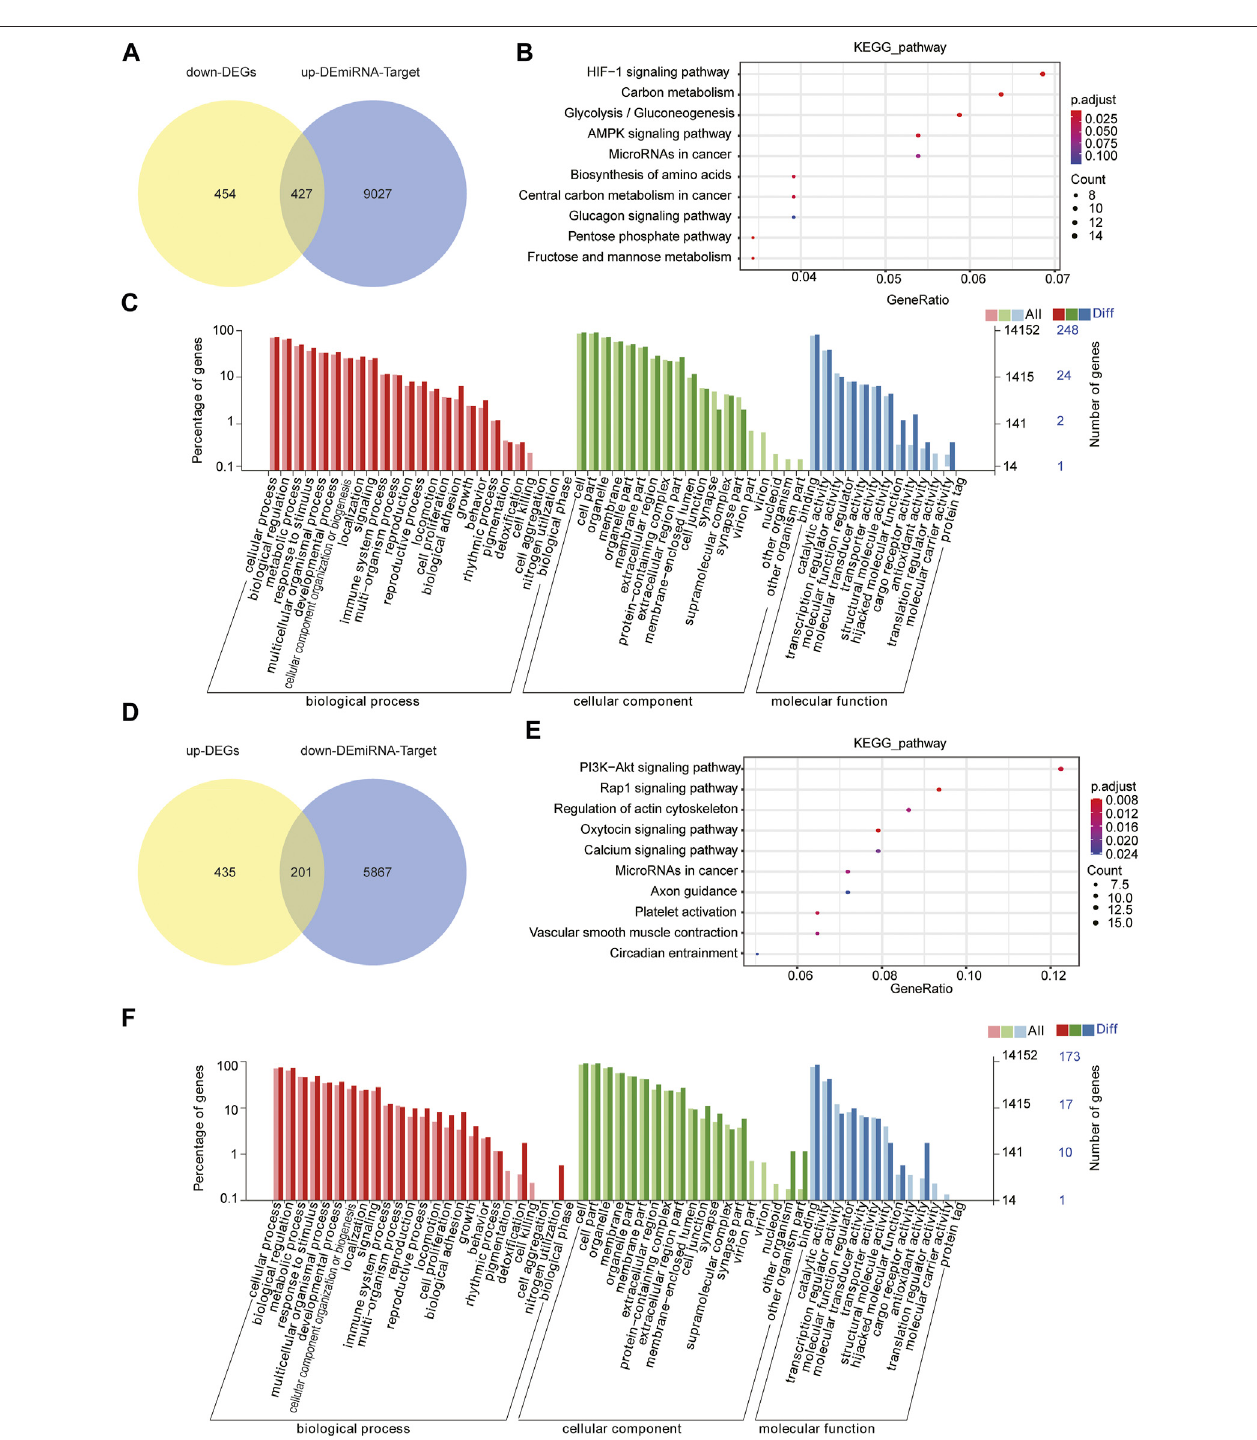
FIGURE 5 | Joint analysis of miRNA and mRNA. (A) Intersection of target genes of upregulated DEMs and downregulated DEGs. (B) Top 10 KEGG pathways the target genes are enriched in. (C) GO analysis of target genes. (D) Intersection of target genes of downregulated DEMs and upregulated DEGs. (E) Top 10 KEGG pathways enrichment of D (F) GO analysis of D through diverse GO